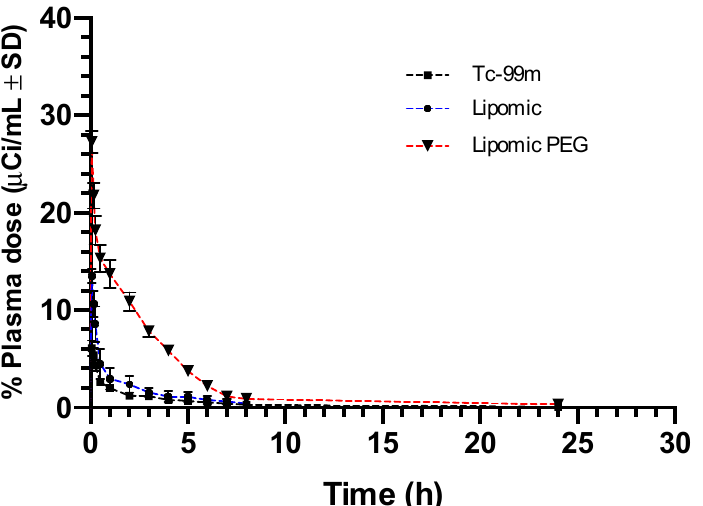
In vivo pharmacokinetics of radiolabeling lipomics (formulation 8.2 with and without PEG) and “free” 99m TcO − are presented in Figure 8, showing their differences. As compared with PEG lipomics, technetium is quickly removed from blood circulation.